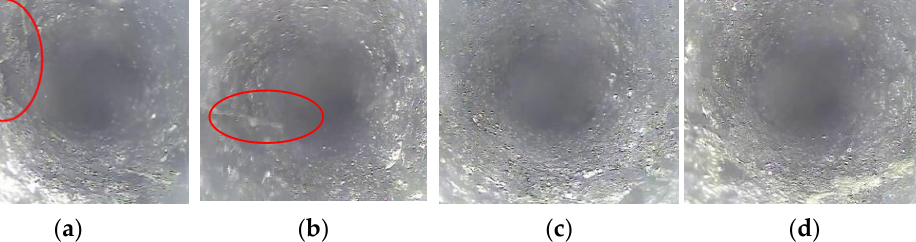
Figure 7. Drilling images of a borehole at different distances from working face side. ( a ) 1.5 m. ( b ) 2.0 m. ( c ) 2.5 m. ( d ) 3.0 m.